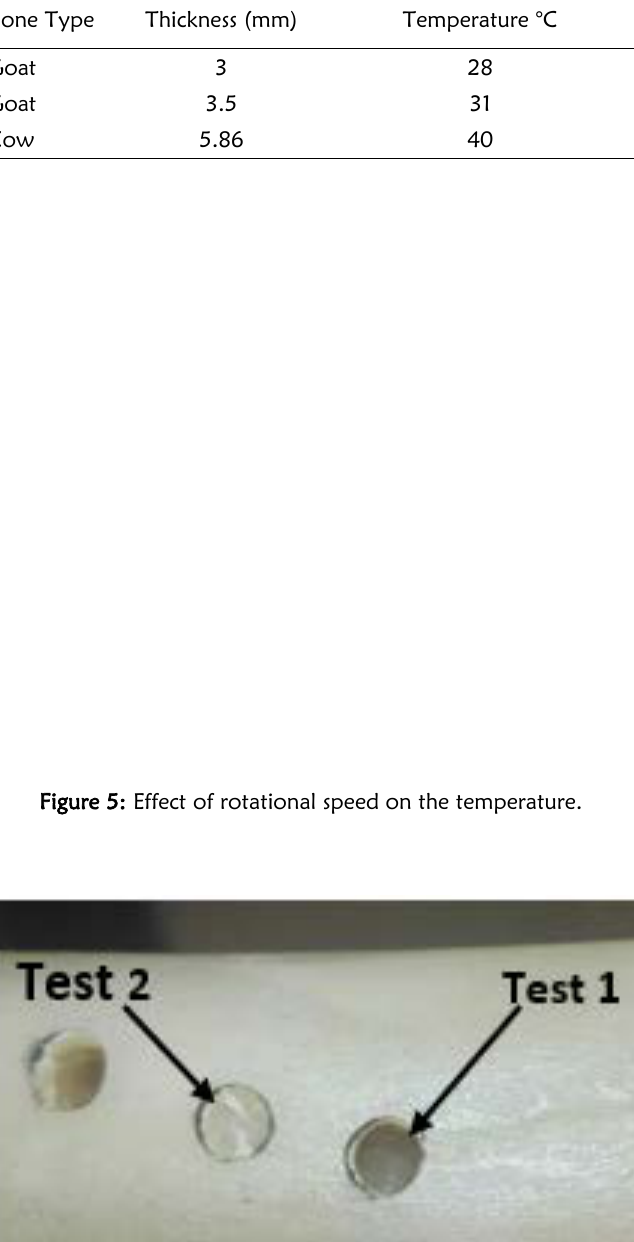
Figure 6: Effect of increasing feed rate and fixing rotational speed at 2000